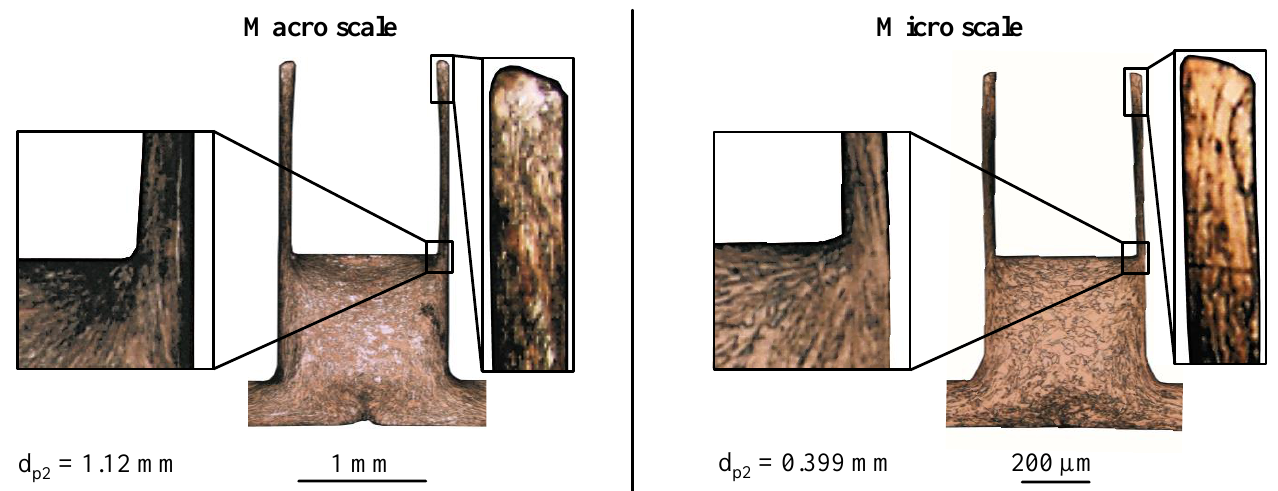
Figure 7. Micrographs of the cup cross-section after extrusion stage 2 for Cu-OFE in the macro and micro scale.